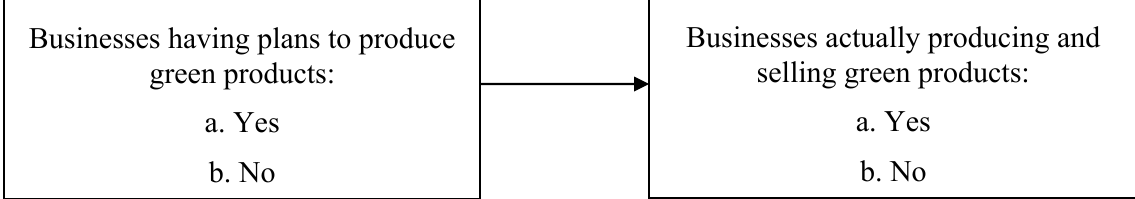
Fig. 1. Relationship of business plan to actual production of green products